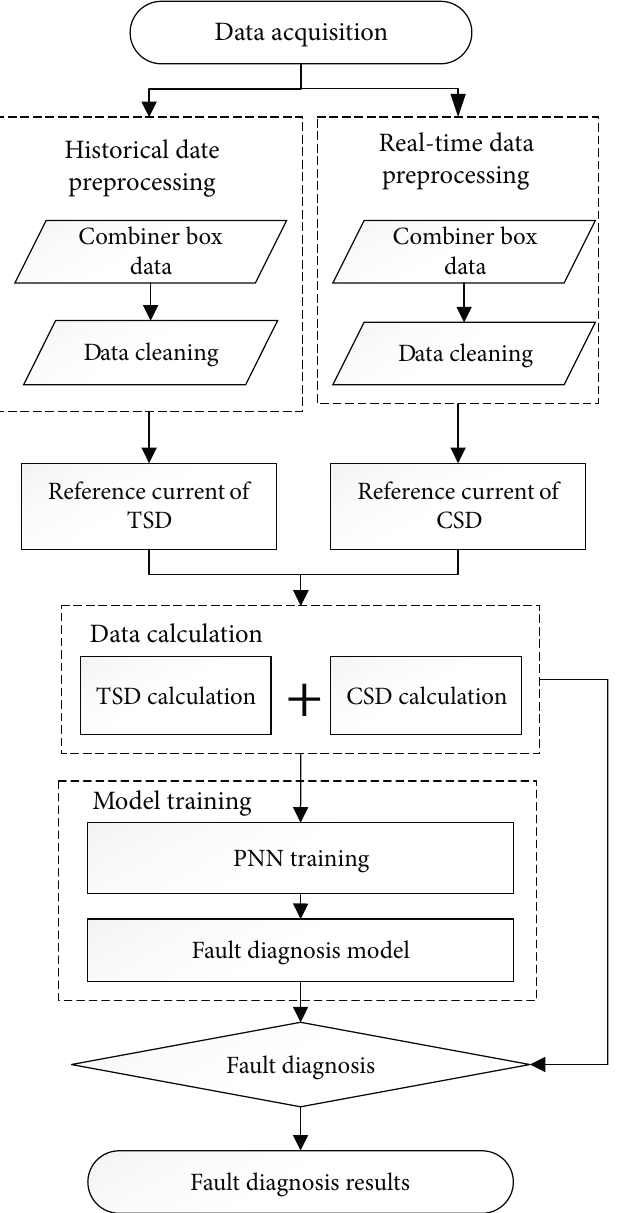
Figure 6: Flow chart of the proposed fault diagnosis